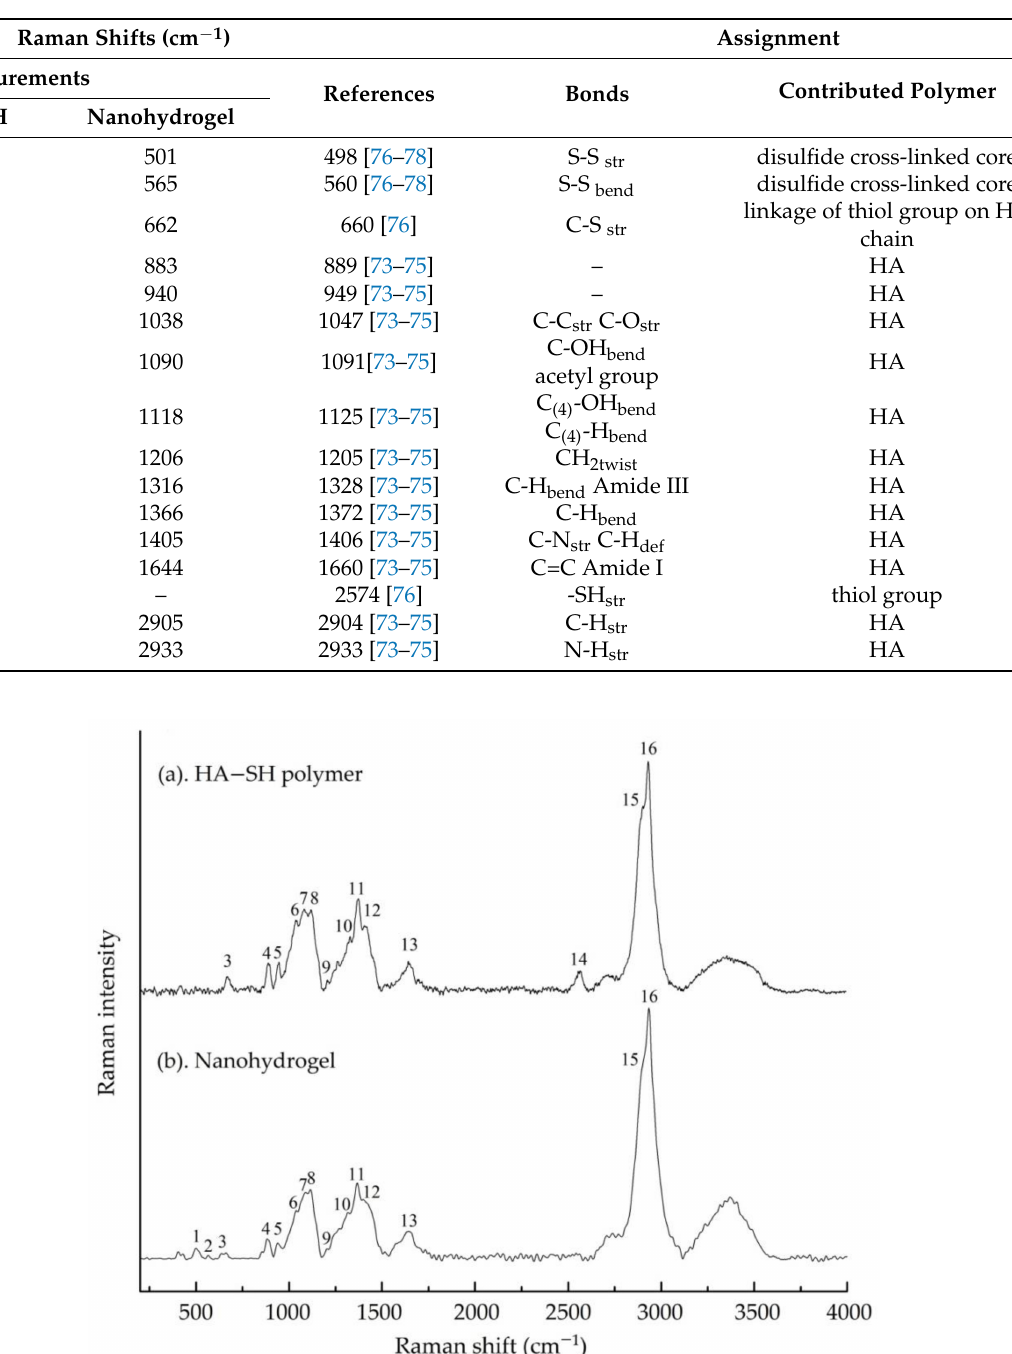
Table 2. Assignment of observed Raman bonds in the HA-SH polymer and the nanohydrogel.